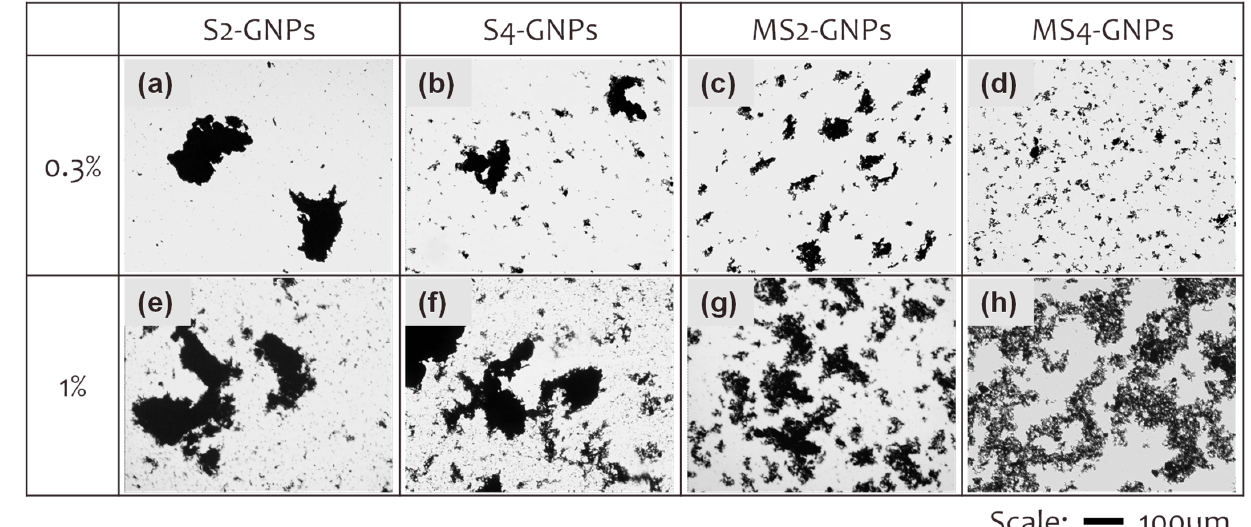
Figure 4. Transmission optical microscopy images of ( a , e ) S2-, ( b , f ) S4-, ( c , g ) MS2- and ( d , h ) MS4- GNPs in epoxy composites. The ( a – d ) and ( e – h ) contained 0.3 and 1 wt% of GNP fillers in the composites, respectively. GNP/epoxy composite films as thin as 1.4 µ m were prepared by pressing and curing them between two glass plates to observe the dispersion states of the GNPs using optical microscopy. Scale bars correspond to 100 µm.